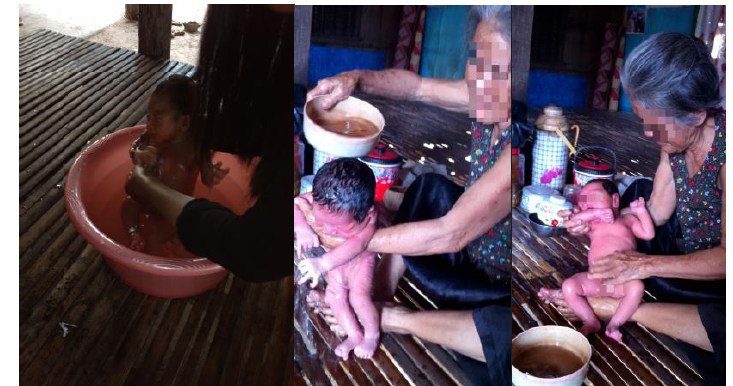
Figure 3. Bathing of newborns.